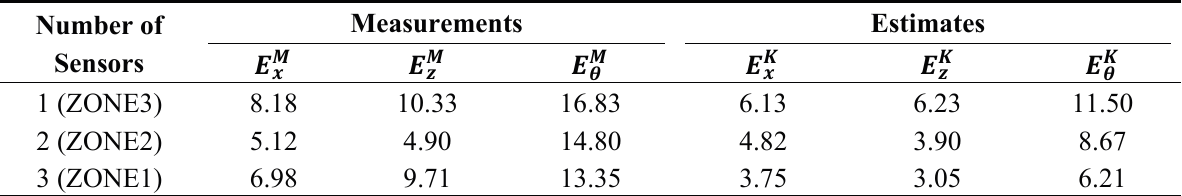
Table 3. MSE errors of multisensor human tracking using different number of sensors in each feature dimension: x , z , and θ